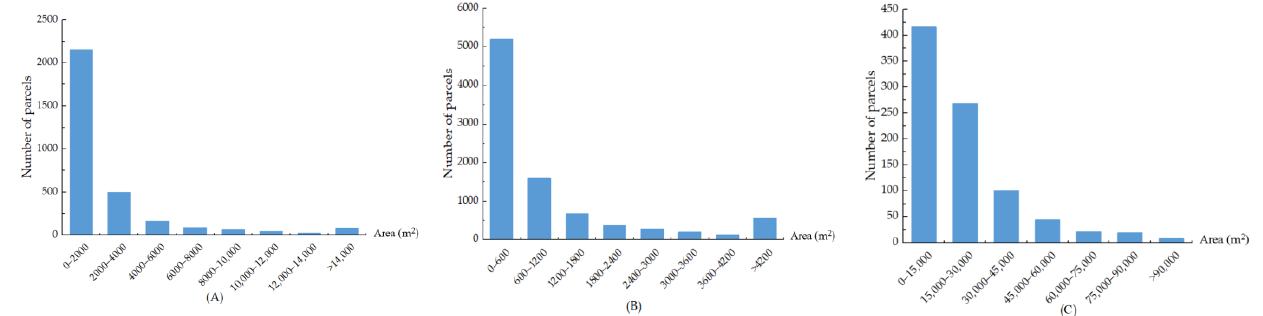
Figure 9. Area statistics of different types of candidate parcels. ( A ) is the area information of regular parcels. ( B ) is the area information of terrace parcels. ( C ) is the area information of slope parcels.